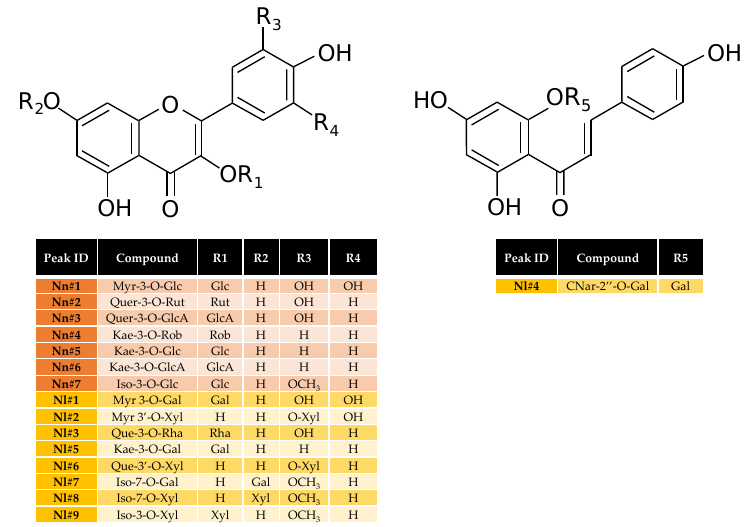
Figure 4. Structures of the mains flavonoids from N. nucifera and N. lotus stamen extracts. Myr: myricetin; Que: quercetin; CNar: chalcononaringenin; Kae: kaempferol; Iso: isorhamnetin; Rut: rutinose; Rob: robinobiose; GlcA: glucuronic acid; Glc: glucoside; Gal: galactoside; Xyl: xyloside; Rha: rhamnoside.